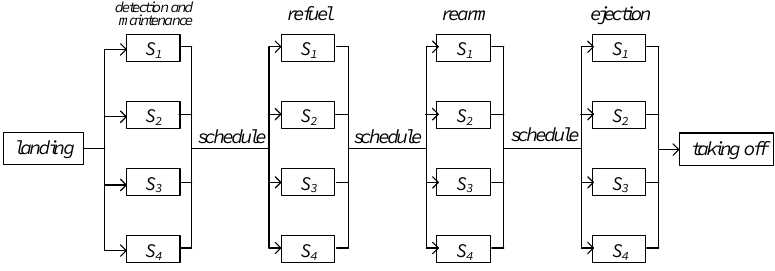
Figure 5. Flow chart of carrier aircraft aviation support scheduling.